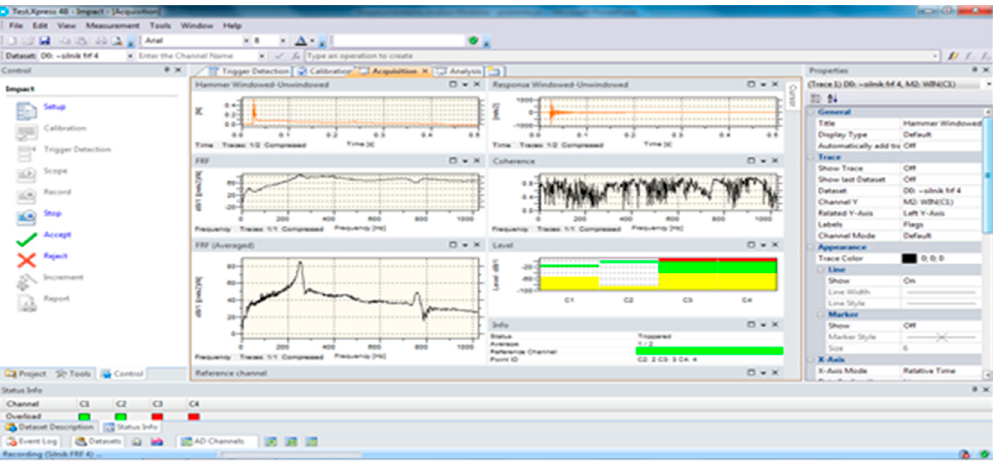
Figure 7. Example view of measuring the time course of the vibration response as a function of time during the registration of measurements in the SIEMENS LMS Test.Xpress v.4.1 software.